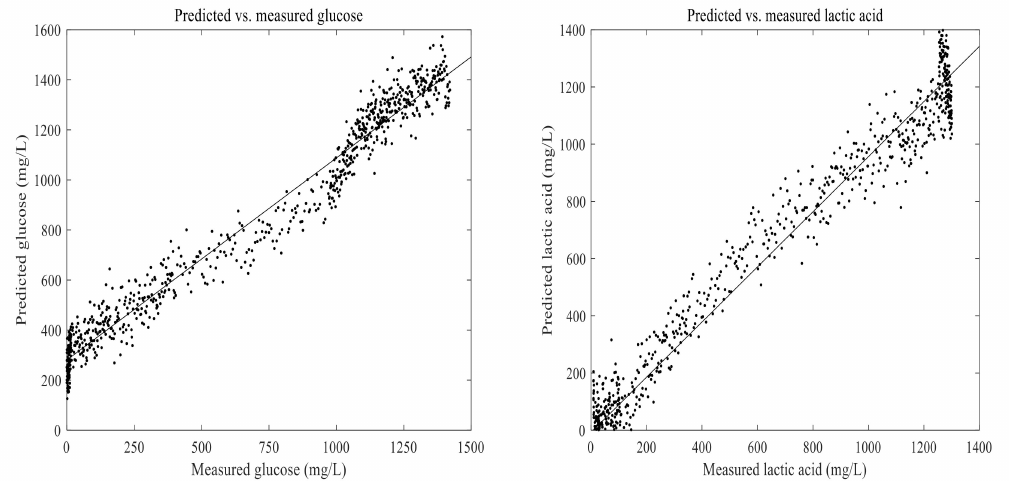
Figure 11. Predicted vs. measured glucose and lactic acid in the fermentation of 7 g/100 mL of sub- strate inoculated with 6 log cfu/mL mixed strains of Lactiplantibacillus plantarum A6 and Lacticaseibacil- lus rhamnosus GG; predicted with partial least-squares regression using seven principal components.